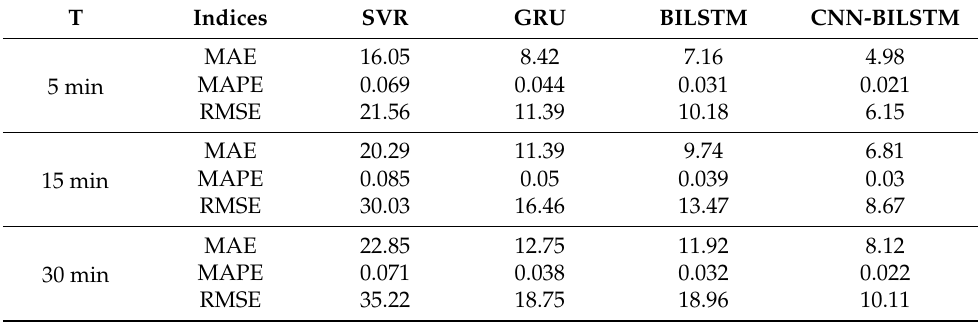
Table 1. Prediction performance of different models at different time